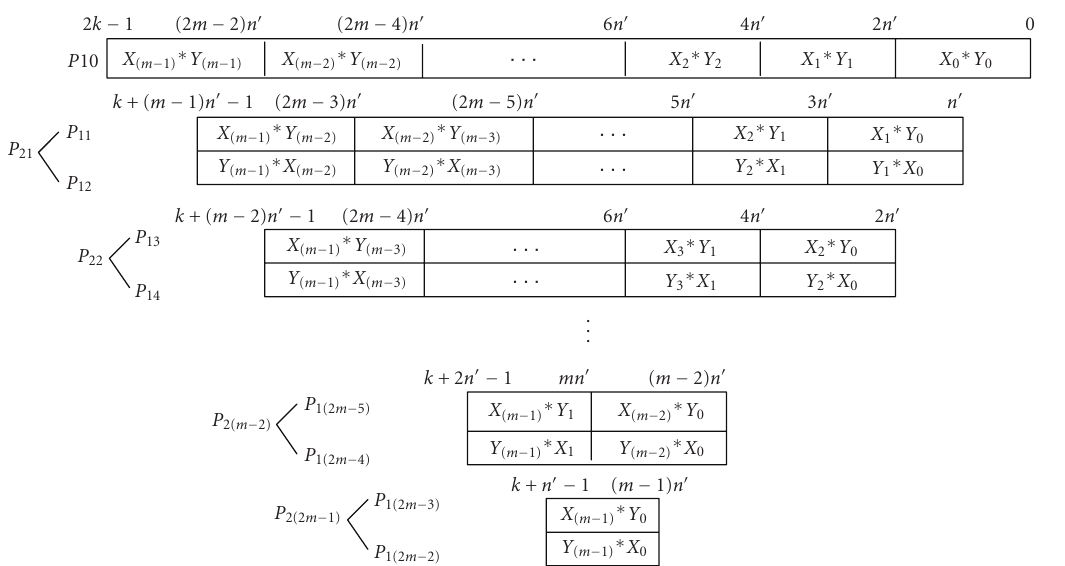
Figure 1: Organization of the partial products of large size signed multiplier.